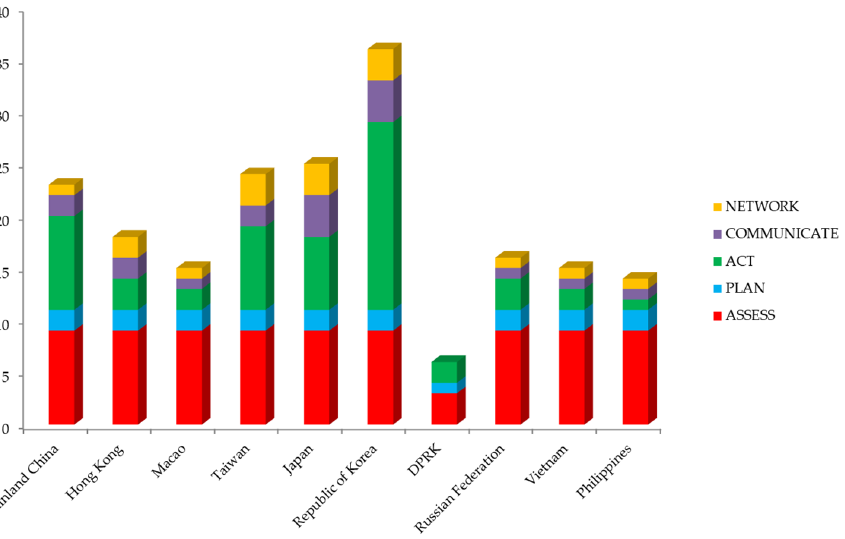
Figure 3. Number of documented activities founded within a SCC framework by countries (including international activities attributed to more than one country; see Table S1).